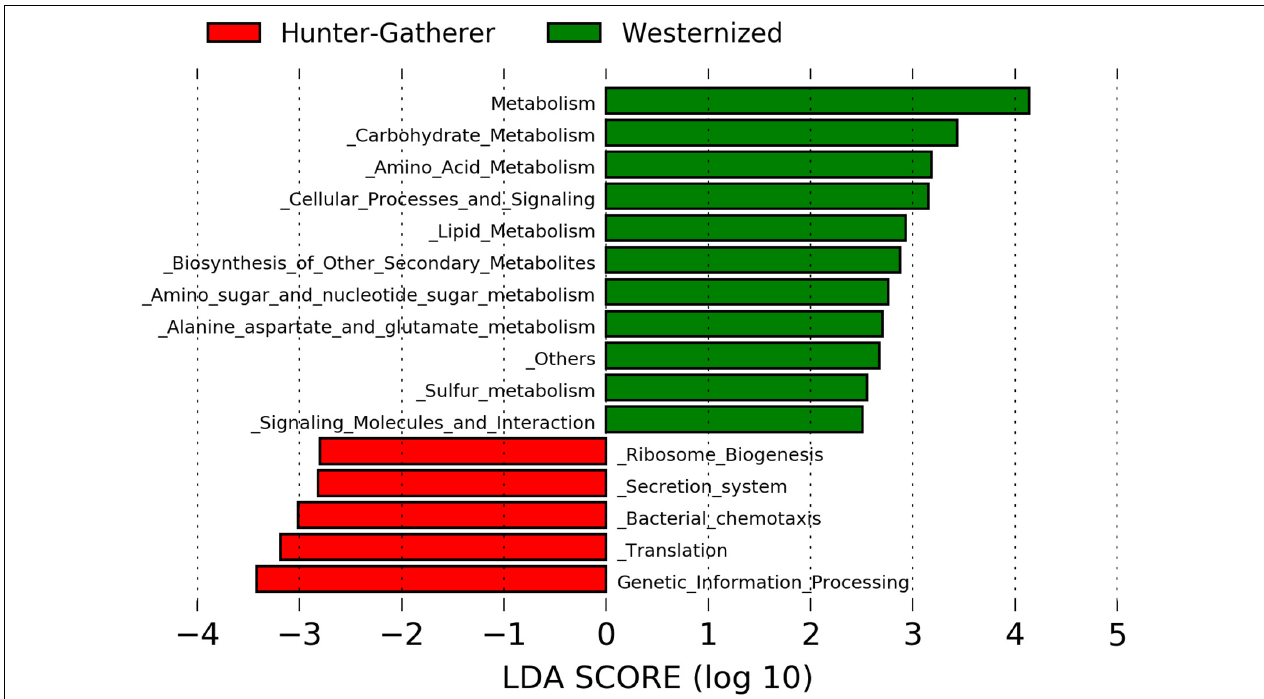
FIGURE 3 | Linear discriminant analysis (LDA) effect size (LEfSe) analysis of the differentially abundant KEEG pathways in hunter-gatherers vs. westernized population. The threshold of the logarithmic LDA score was 2.0.